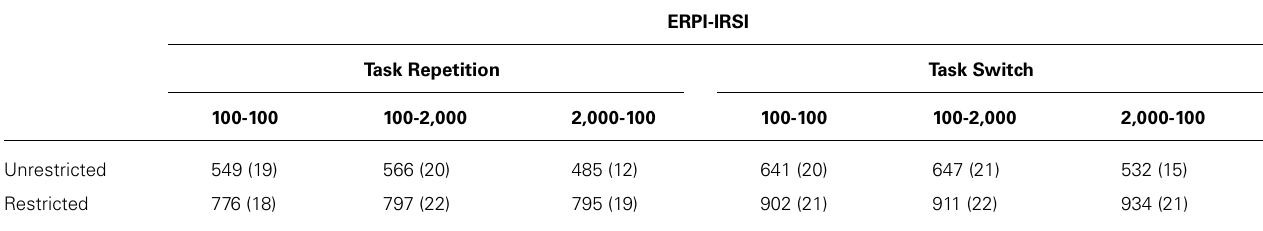
Table 2 | Mean task indication RTs as a function of ERPI-IRSI combination,TaskTransition, andTask Choice (SEM in parentheses).